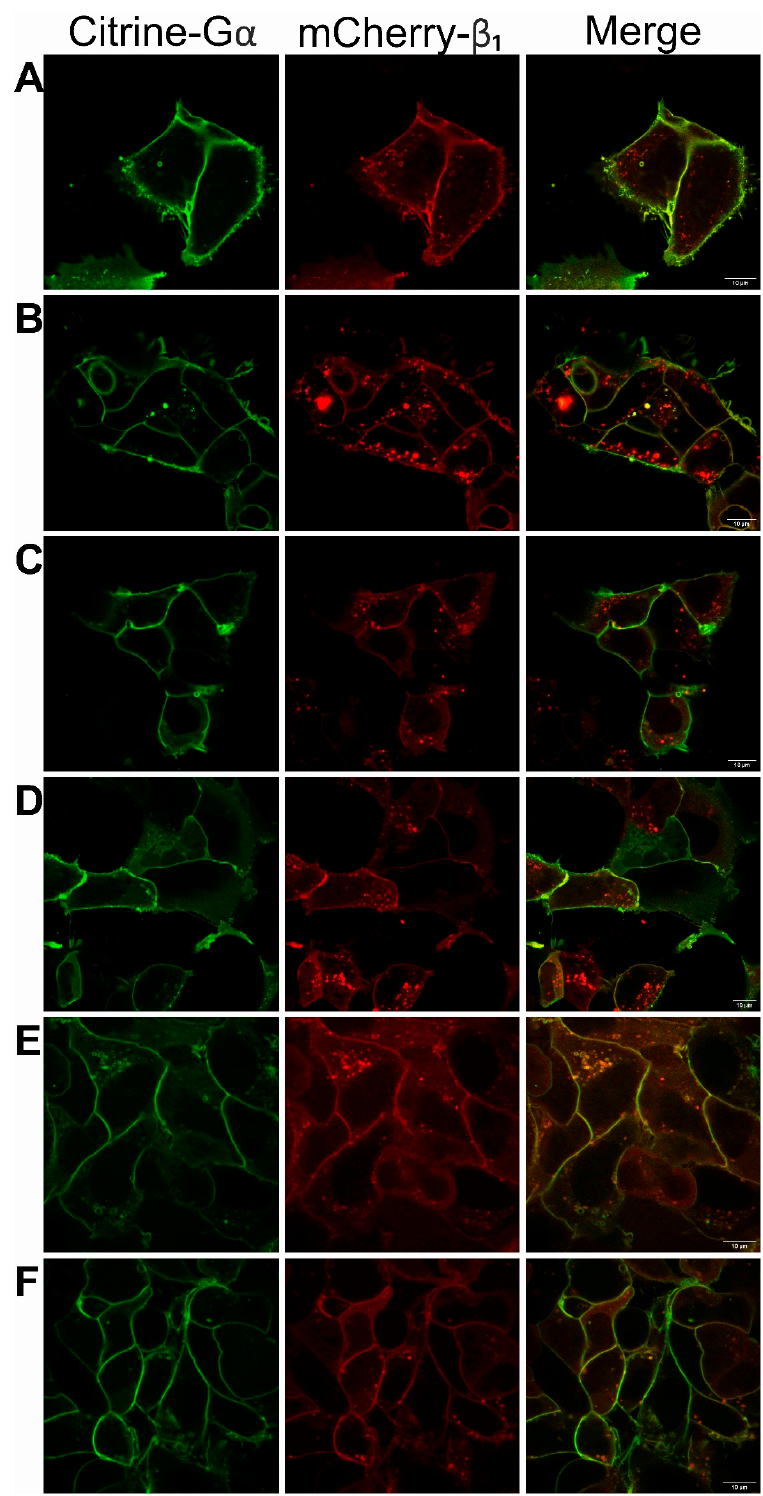
Figure 1. Cellular localization of G α s β 1 γ 2 , G α s β 1 γ 9, G α i 3 β 1 γ 2 , and G α i 3 β 1 γ 9 heterotrimers. Representative confocal images of fluorescent protein (FP)-tagged Citrine–G α subunits and mCherry–G β 1 γ dimers in transiently co-transfected HEK 293 cells. Localization of heterotrimers: ( A ) G α s β 1 γ 2 , ( B ) G α s β 1 γ 9 , ( C ) G α s iek β 1 γ 2 , ( D ) G α s iek β 1 γ 9 , ( E ) G α i 3 β 1 γ 2 , ( F ) G α i 3 β 1 γ 9 . Scale bar, 10 µ